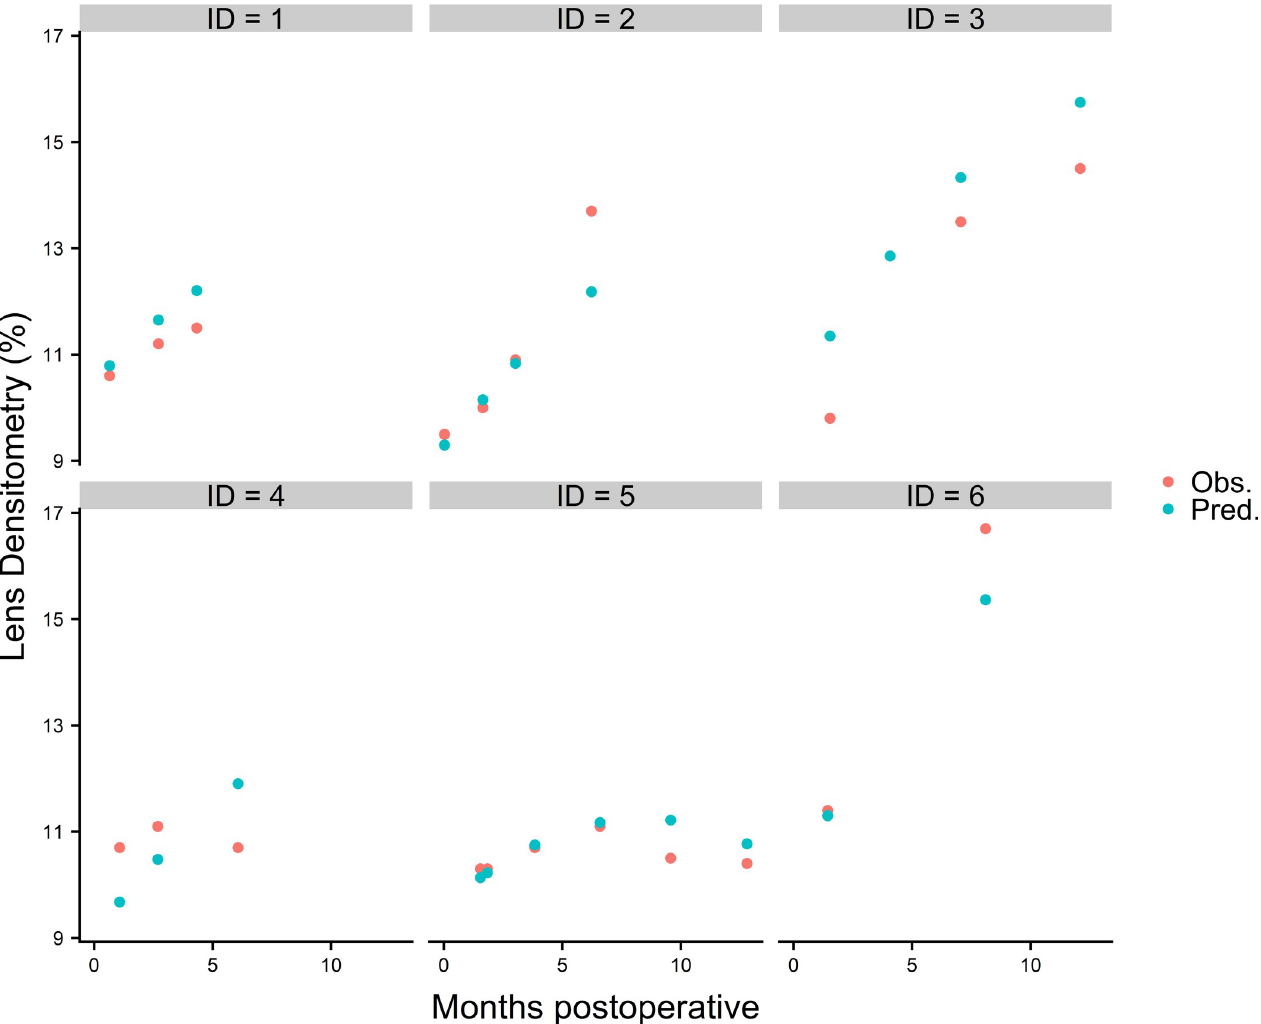
Fig 3. Predicted and observed lens densitometries over time. Predicted (blue dots) and observed (red dots) postoperative lens densitometries over time.